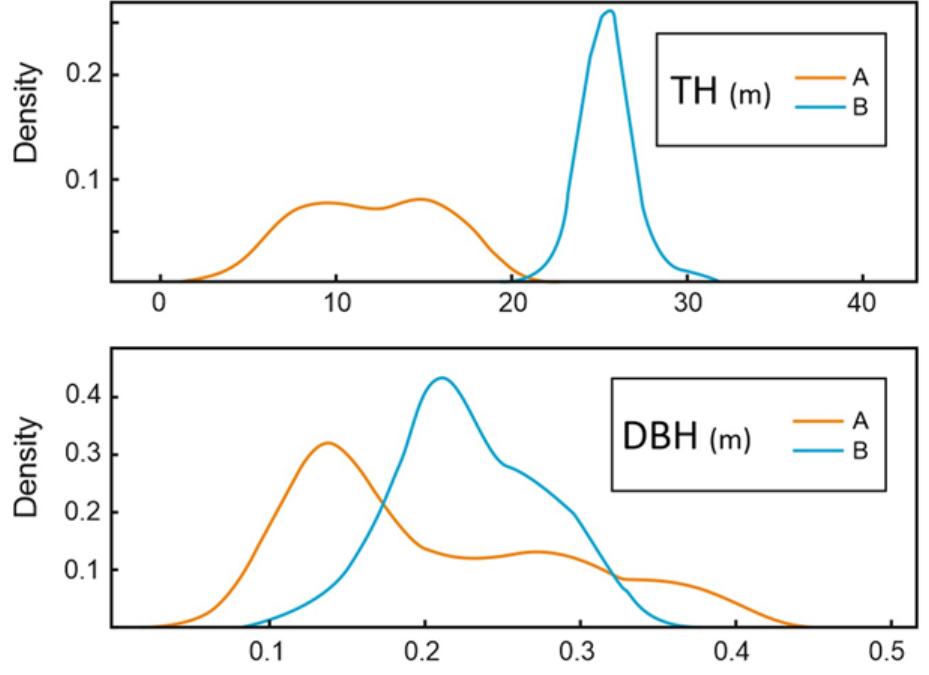
Figure 15. Probability density functions for DBH and TH at test sites A and